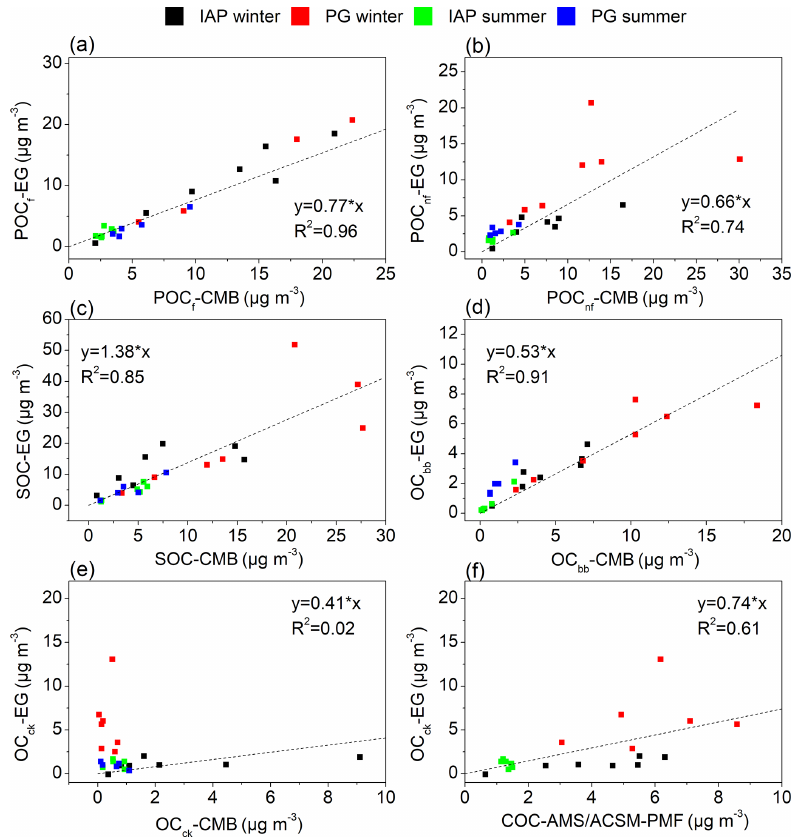
Figure 5. Correlations of OC sources from the extended Gelencsér method with those from the CMB model. EG denotes the extended Gelencsér method, (a) primary OC from fossil sources, (b) primary OC from non-fossil sources, (c) secondary OC, (d) OC from biomass burning, (e) OC from cooking, (f) correlations of OC ck from extended Gelencsér method and AMS/ACSM-PMF model (AMS for IAP and ACSM for PG). Good correlations were found within the apportionments of POC f , POC nf , SOC, and OC bb between the CMB and EG method and large discrepancies of OC ck . The PMF model did not show certain source apportionment results from fossil, non-fossil, or secondary OC; i.e. only OC ck concentrations were